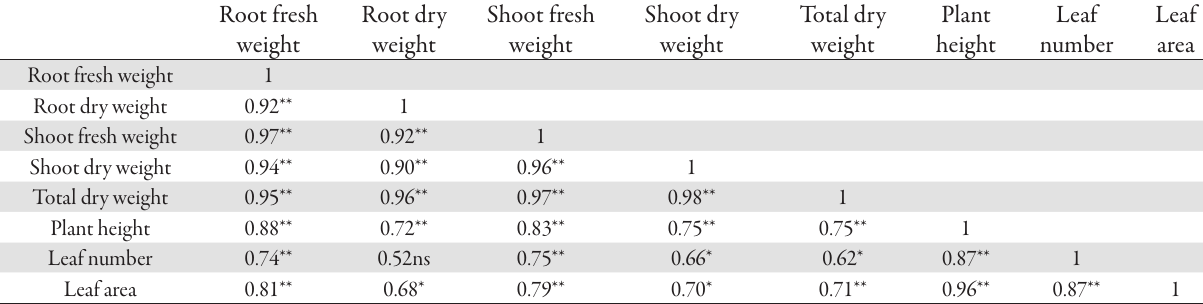
Within each column followed by the same letter are not significantly differences (p < 0.05) Tab. 3. Pearson correlations between growth parameters affected by salt stress